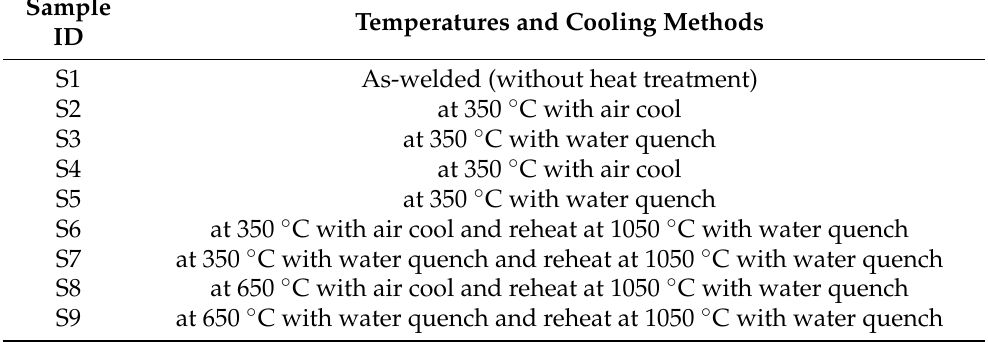
Table 3. Post weld heat treatment